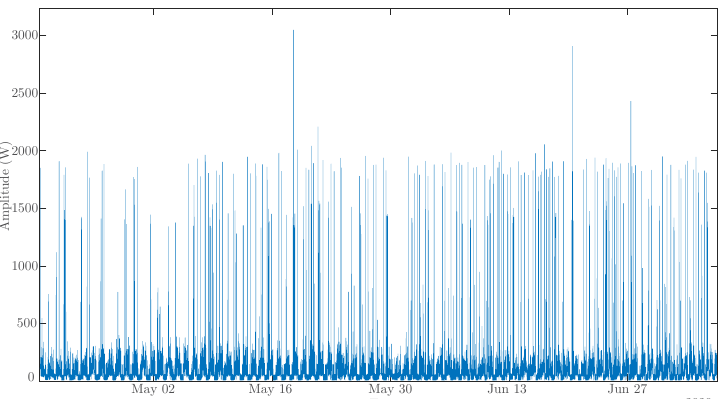
Figure 7. WP electricity consumption of household